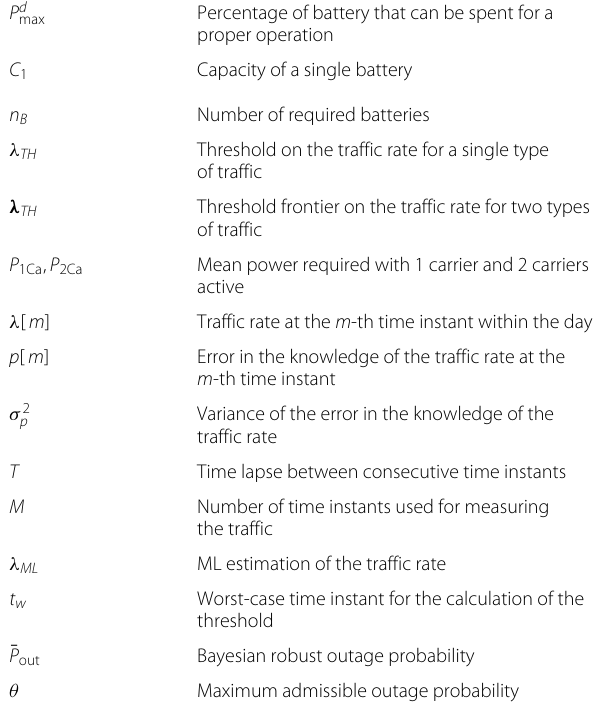
Table 6 List of parameters and symbols used in the paper (Continued)